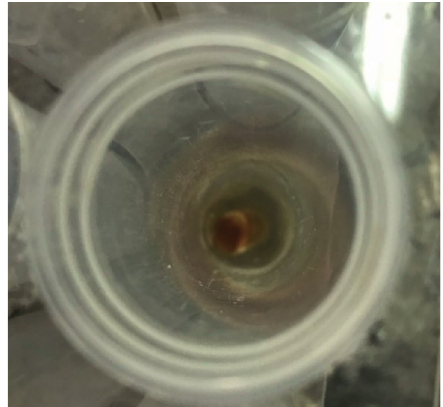
Figure 8: Dried spore powder after centrifugation and